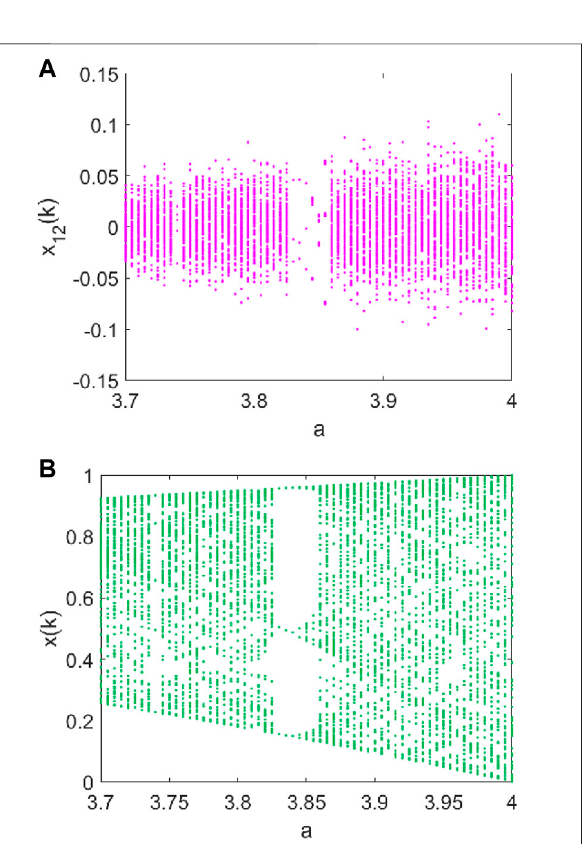
FIGURE9| Invarianceofthebifurcationpoints forhighervaluesof N : (A) Bifurcation diagram for the multidimensional logistic map with N = 100; (B) bifurcation diagram for the scalar logistic map. Diagrams are evaluated with respect to a ∈ [ 3 . 7 , 4 ] .